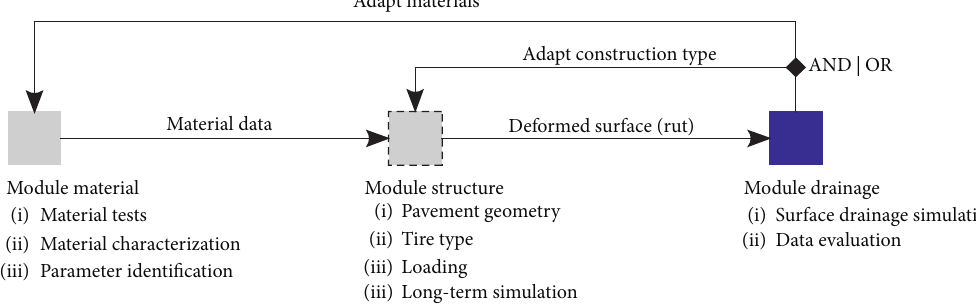
Figure 2: Flowchart of the modular